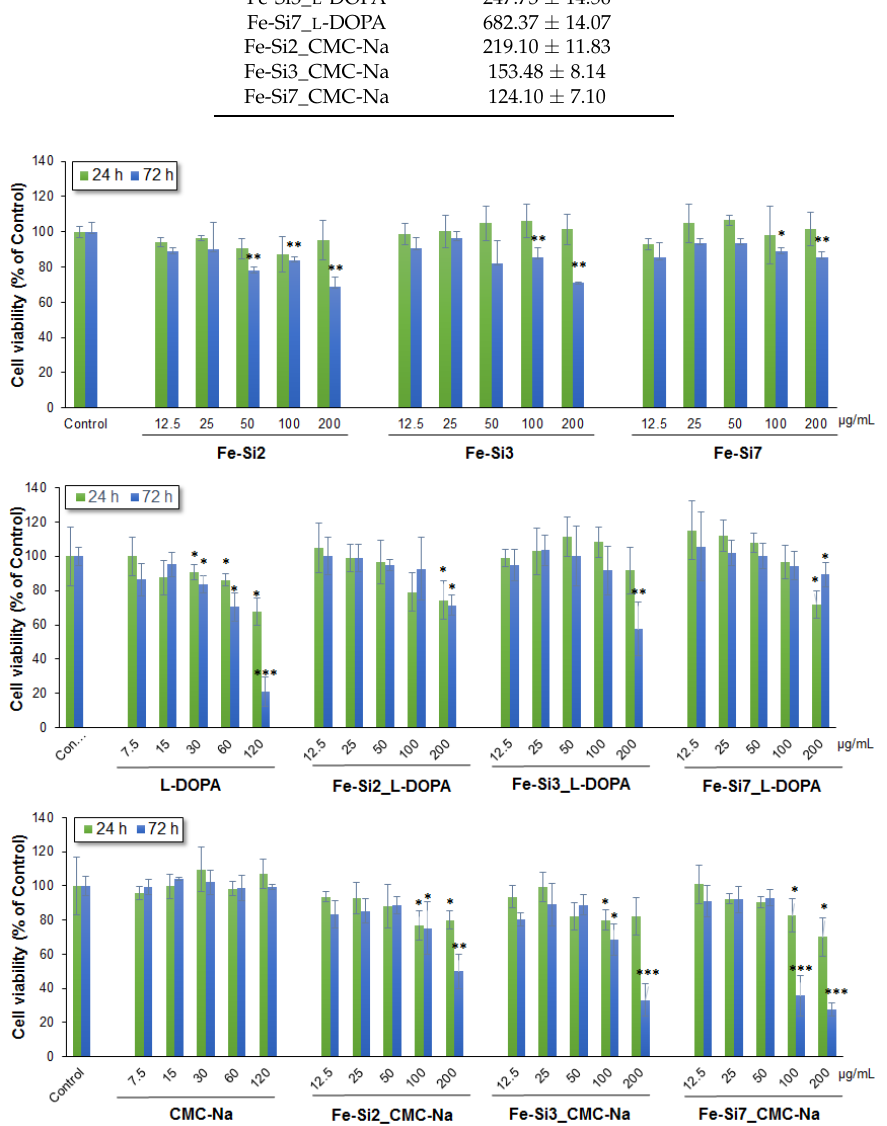
Figure 6. Cell viability of Caco2 cells after 24 and 72 h exposure to different doses (0–200 µg/mL) of hybrid Fe-Si NPs alone and stabilized with L -DOPA and CMC-Na (0–120 µg/mL). Data are expressed as the mean ± SD ( n = 3) and represented as percentages of untreated control (100% viability). * p < 0.05; ** p < 0.01; *** p < 0.001 versus untreated control.